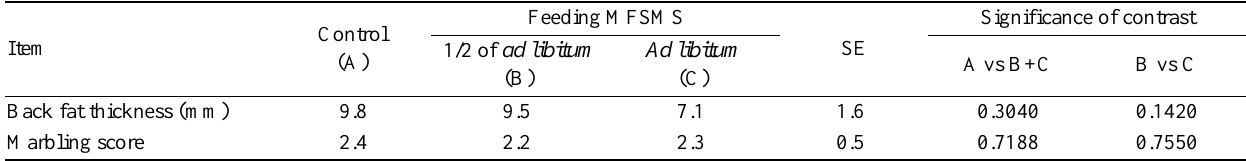
Table 4. Effect of dietary supplementation of microbially-fermented spent mushroom substrates (MFSMS) on back fat thickness and marbling score of Hanwoo steers measured by ultrasound scanning 1, 2